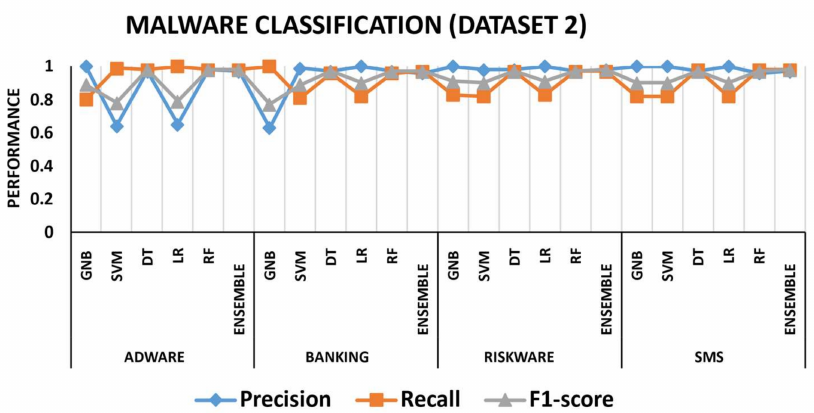
Figure 10. Performance measure (precision, recall, f1-score) comparisons for malware detection dataset